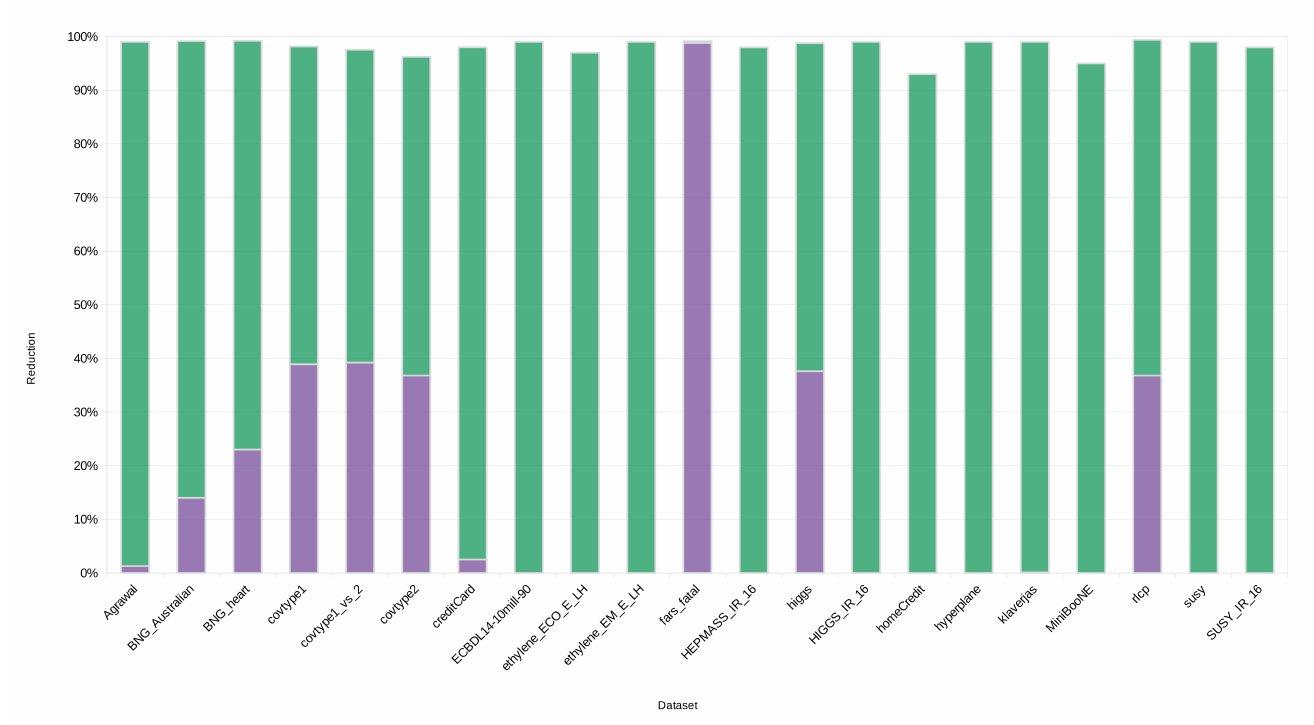
Figure 2. Volume reduction by drop repeated instances (violet) and uniform sampling